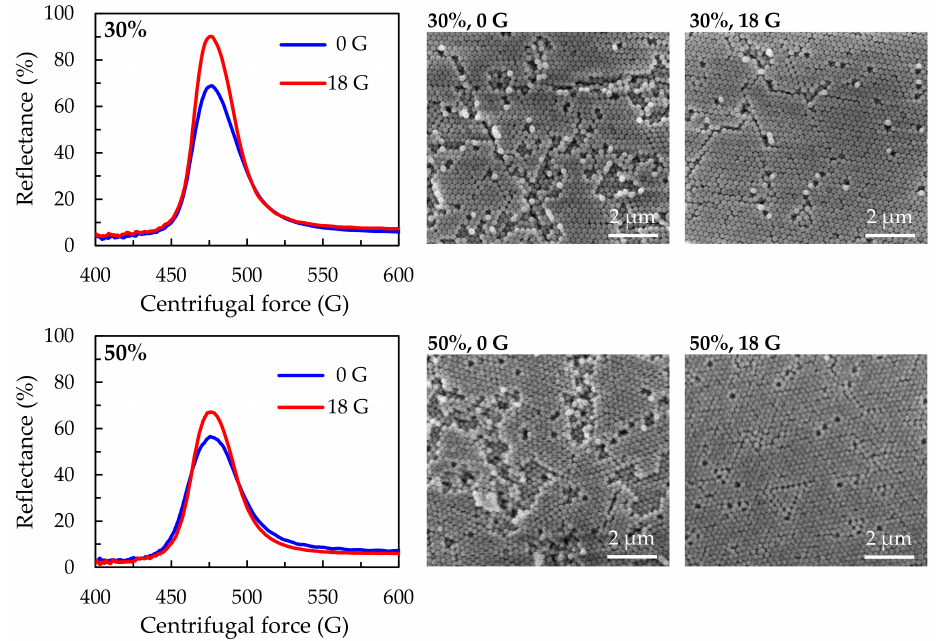
Figure 7. Reflection spectra and SEM images of samples stacked at 0 and 18